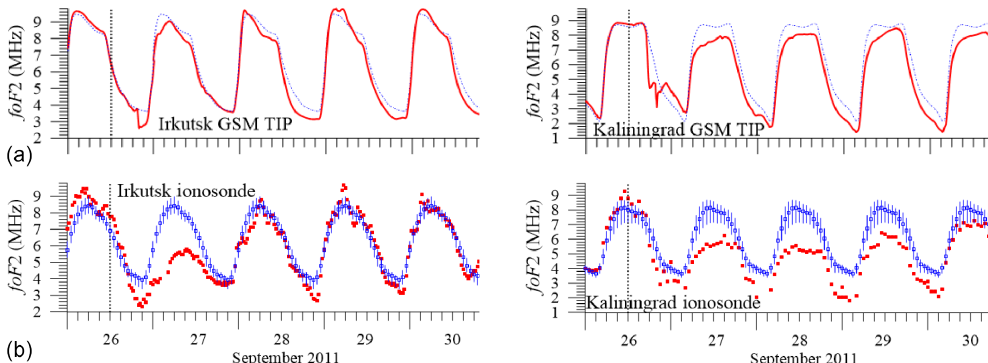
Figure 2. Variations in the fo F2 (red) above Irkutsk and Kaliningrad during 26–30 September 2011: (a) the GSM TIP calculation results and (b) ionosonde data. Blue shows the quiet geomagnetic conditions, with 27-day median and interquartile range bars for ionosonde observations.